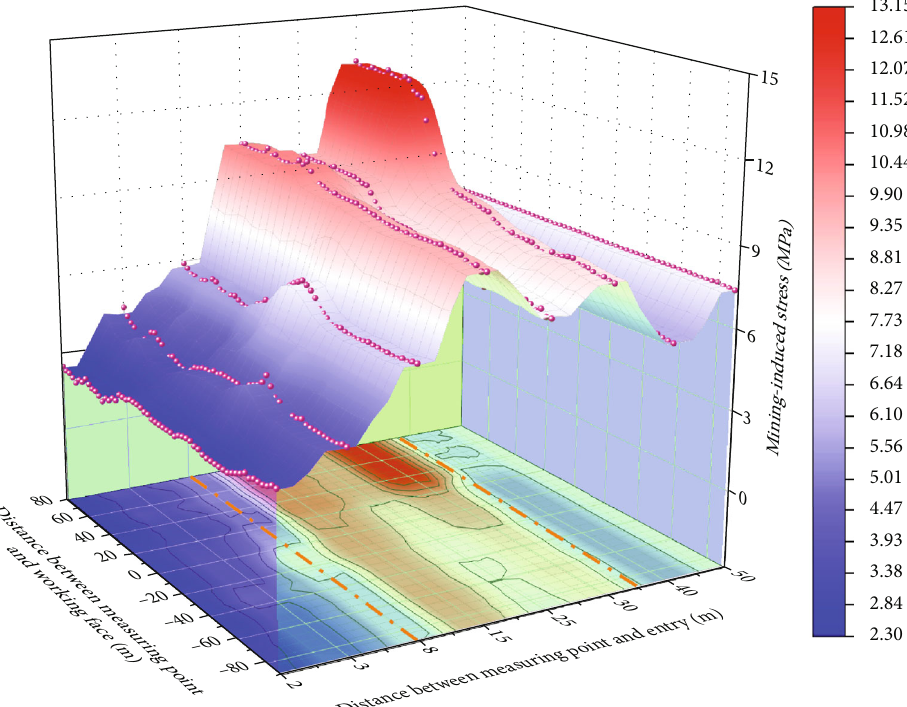
Figure 9: The mining-induced stress data of the borehole at the measuring point in the coal